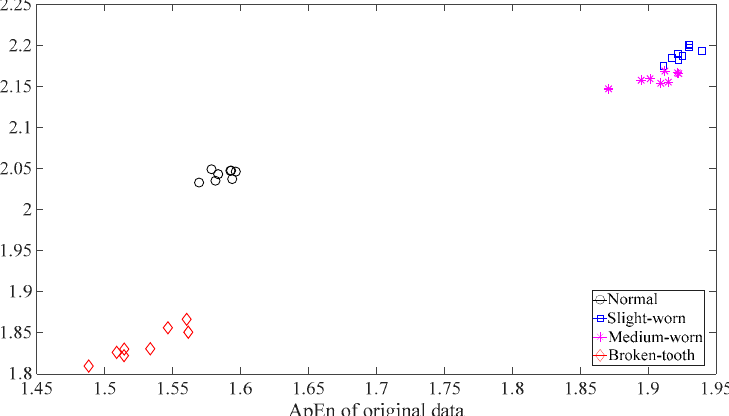
Figure 10. Two-dimensional EnEn of the two detail components most correlated with the original data for each of the four types of gear condition. In this case, the first detail components are selected for use.